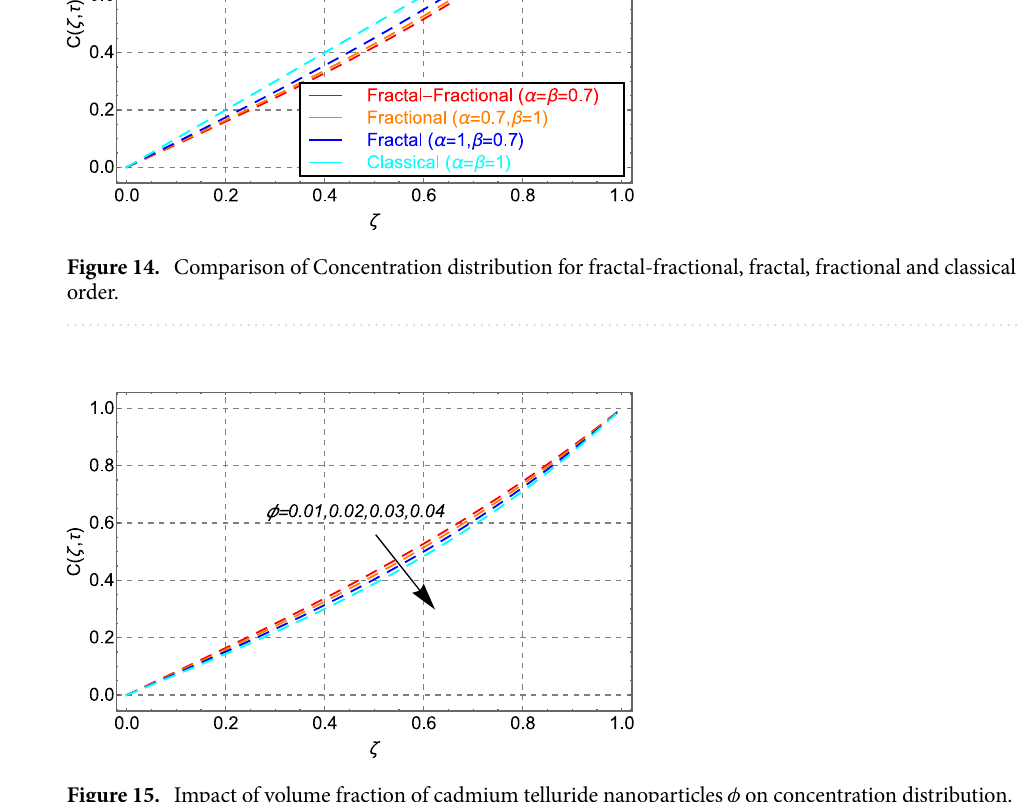
Figure 15. Impact of volume fraction of cadmium telluride nanoparticles φ on concentration